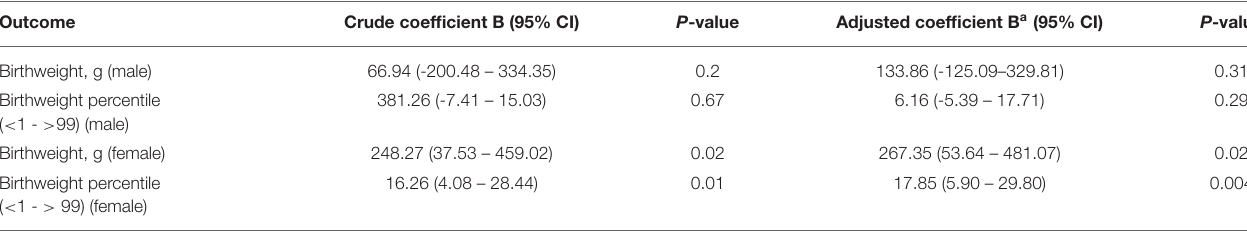
TABLE 6 | Birthweight and birthweight percentiles (crude and adjusted coefficient B) for singleton male and female birth after frozen-thawed embryo transfer in the absence ( n = 114) or presence ( n = 68) of a corpus luteum.